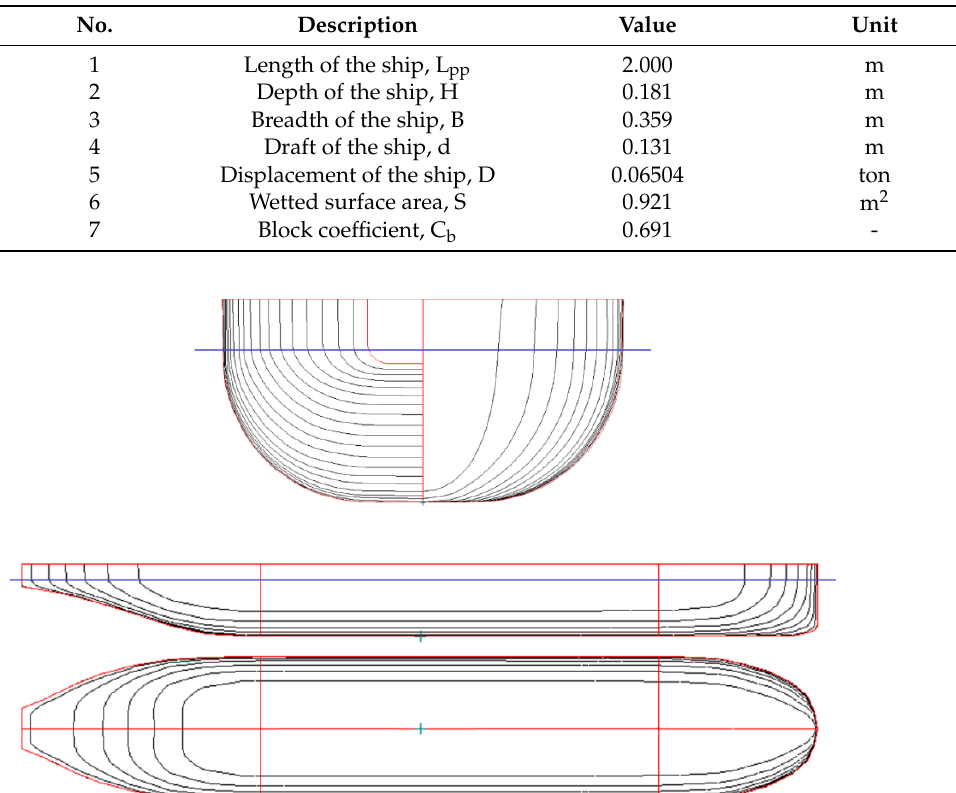
Table 1. Principal dimensions of the original NBS.